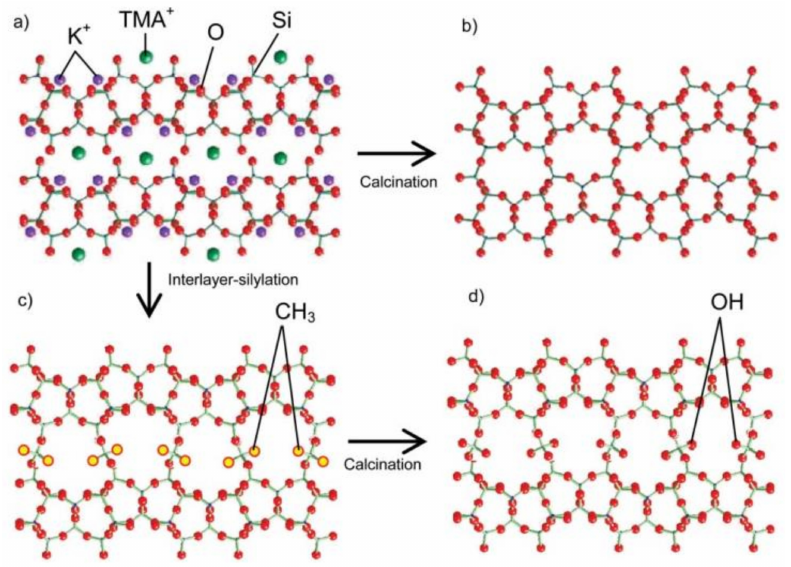
Figure 14. Possible schemes for the formation of the interlayer-expanded structure by the intercalation of DCDMS molecules: ( a ) PLS-1, ( b ) CDS-1, ( c ) IEZ-PLS-1, and ( d ) IEZ-CDS-1. Reprinted with permission from ref. [47]. Copyright 2007, Royal Society of